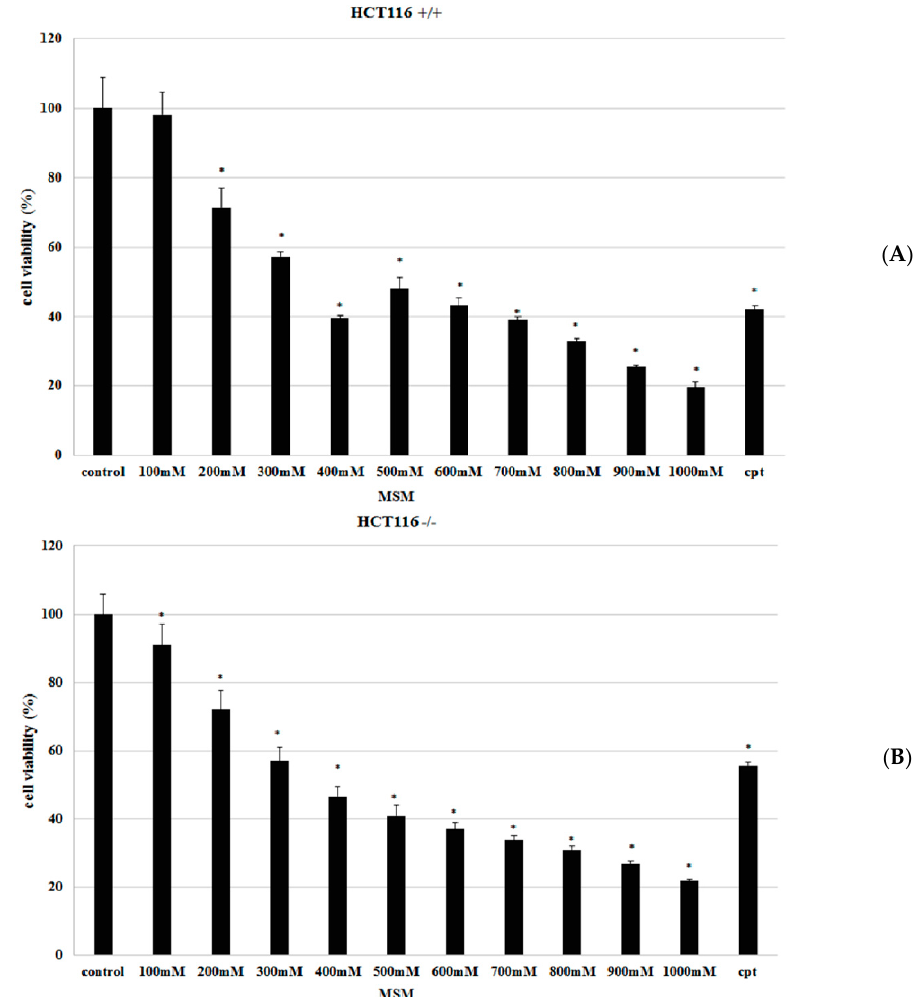
Figure 1. Effect of methylsulfonylmethane (MSM) (100–1000 mM) on cell viability of HCT-116 p53 +/+ and HCT-116 p53 ´ / ´ colon cancer